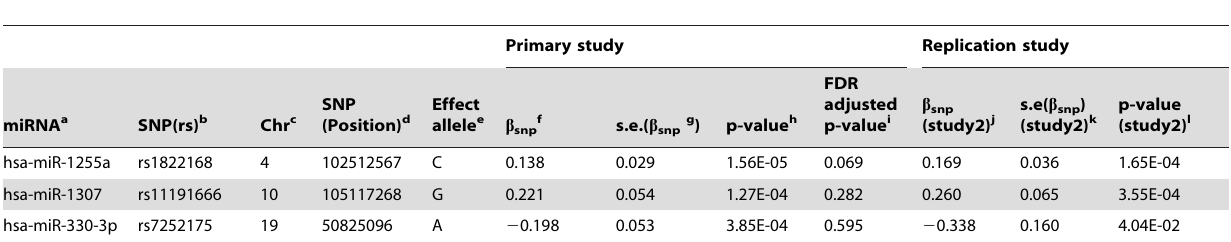
Primary study Replication